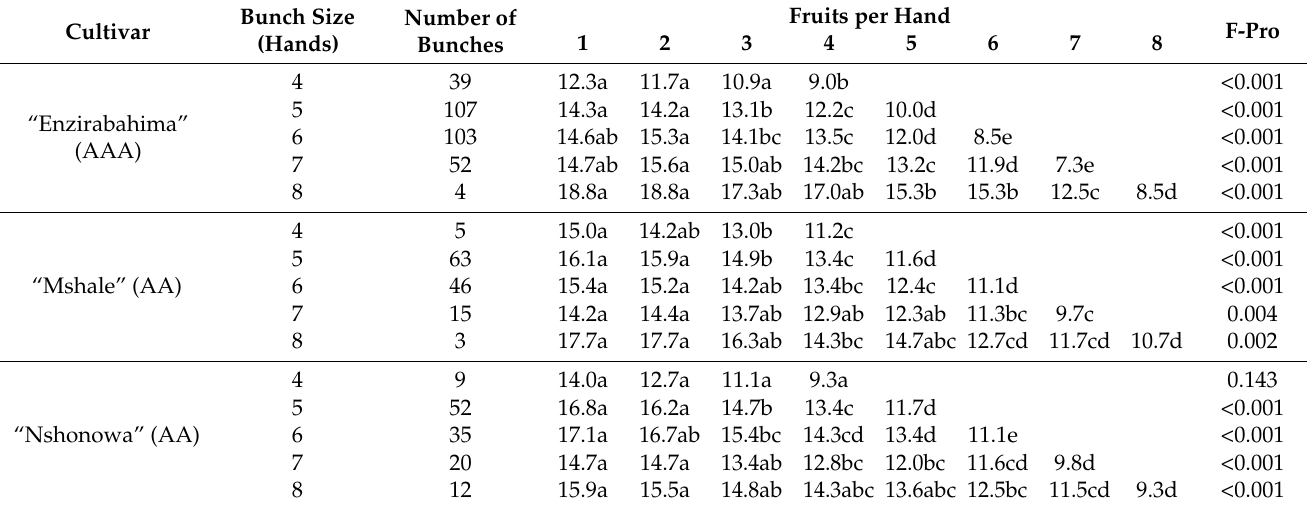
Table 2. Mean fruits per hand for different bunch sizes of “Enzirabahima”, “Mshale”, and “Nshonowa”.